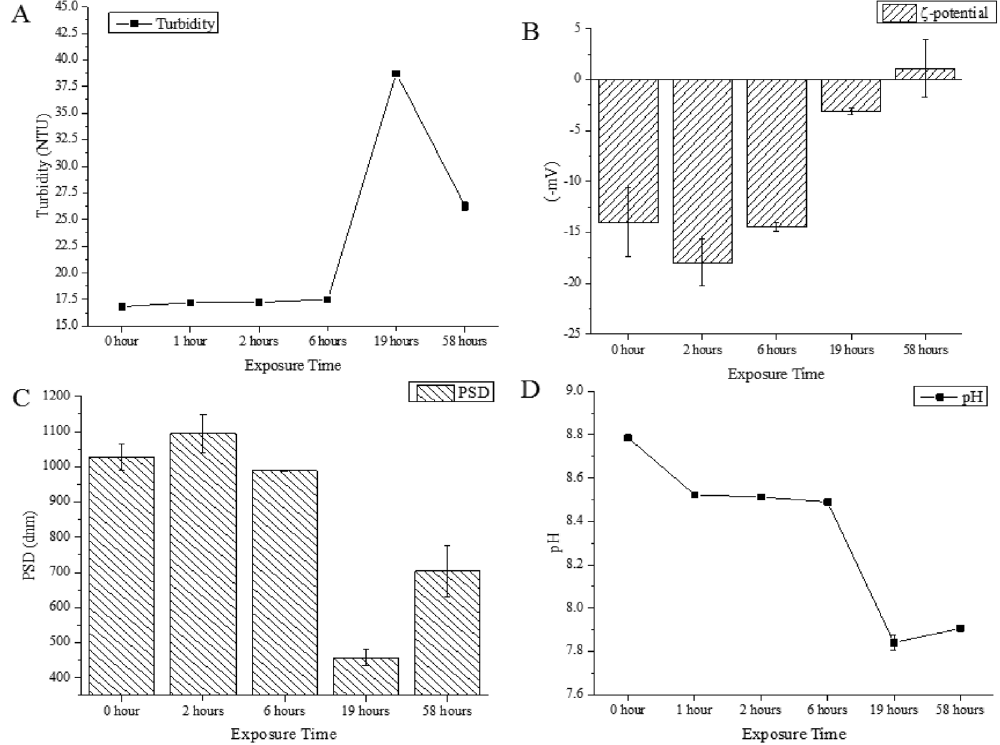
Figure 3. EPS transformation to TEP and flocculation measured as: ( A ) photo-flocculation of EPS upon light exposure, measured as turbidity (NTU); ( B ) ζ− potential ( − mV) of light exposure; ( C ) particle size distribution (dnm) of EPS treated in sunlight; ( D ) changes in pH of EPS in light conditions after exposure in sunlight. Only daylight exposure hours (12 hours per day) were counted, to the exclusion of night